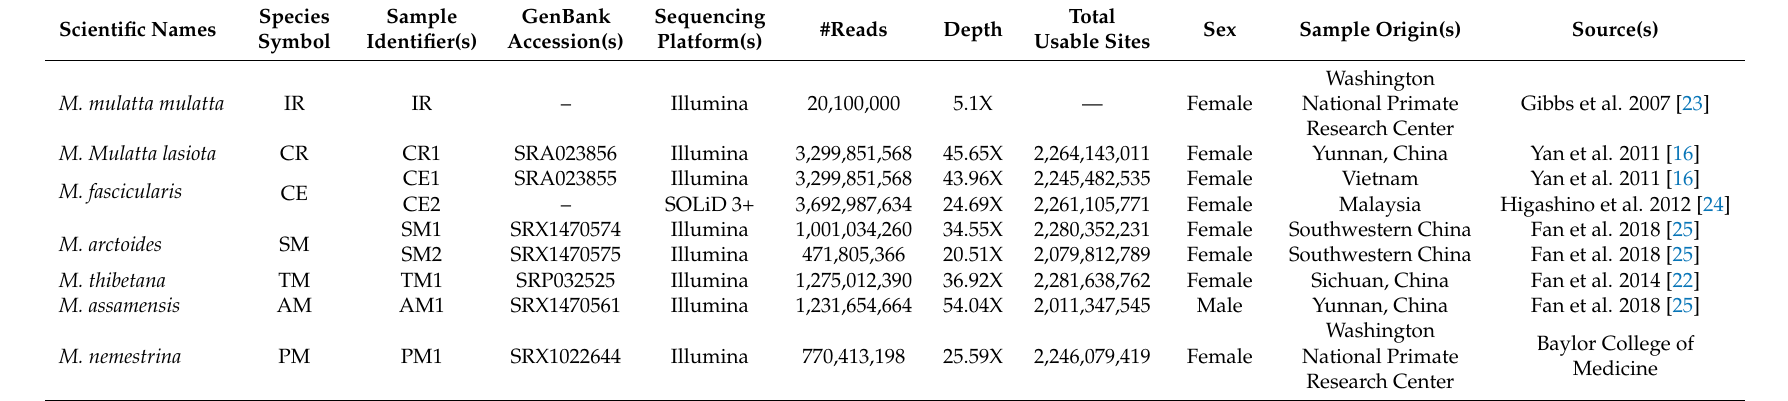
Table 1. Information on genome data.